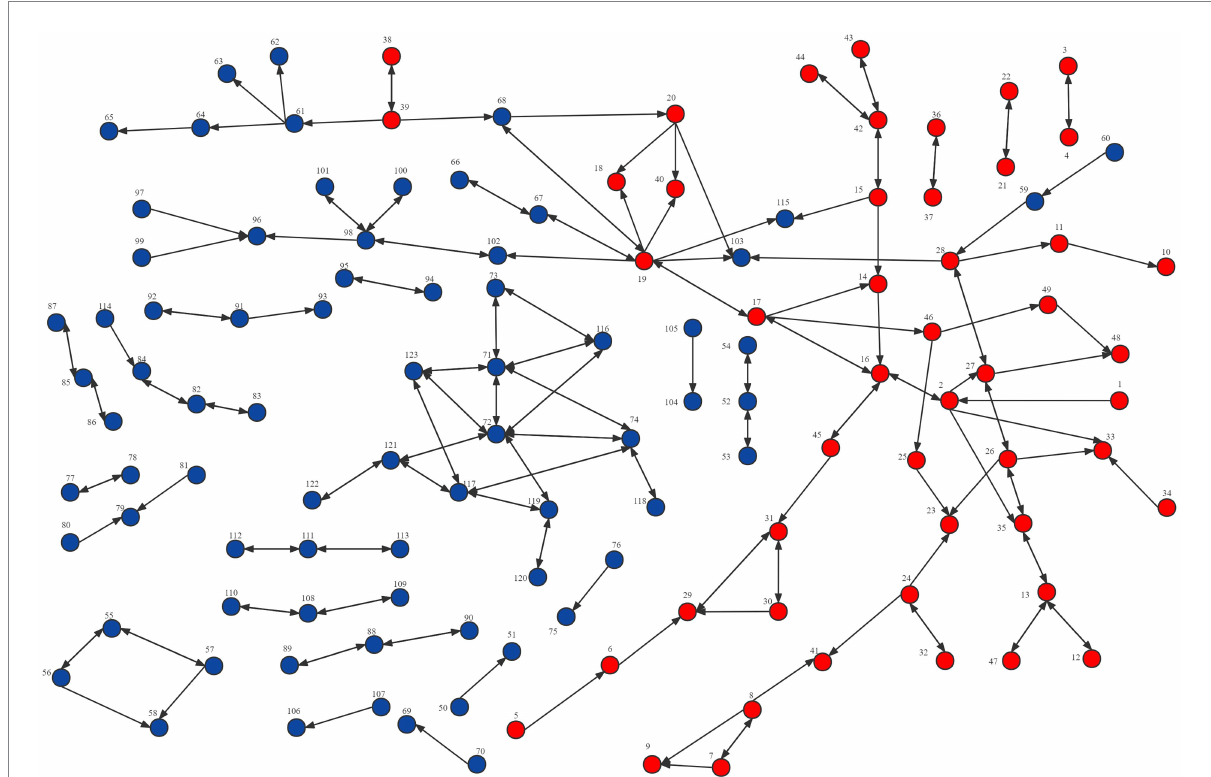
FIGURE 2 Network visualization of the overall knowledge sharing network for health technology in the Fujian liver disease specialist medical